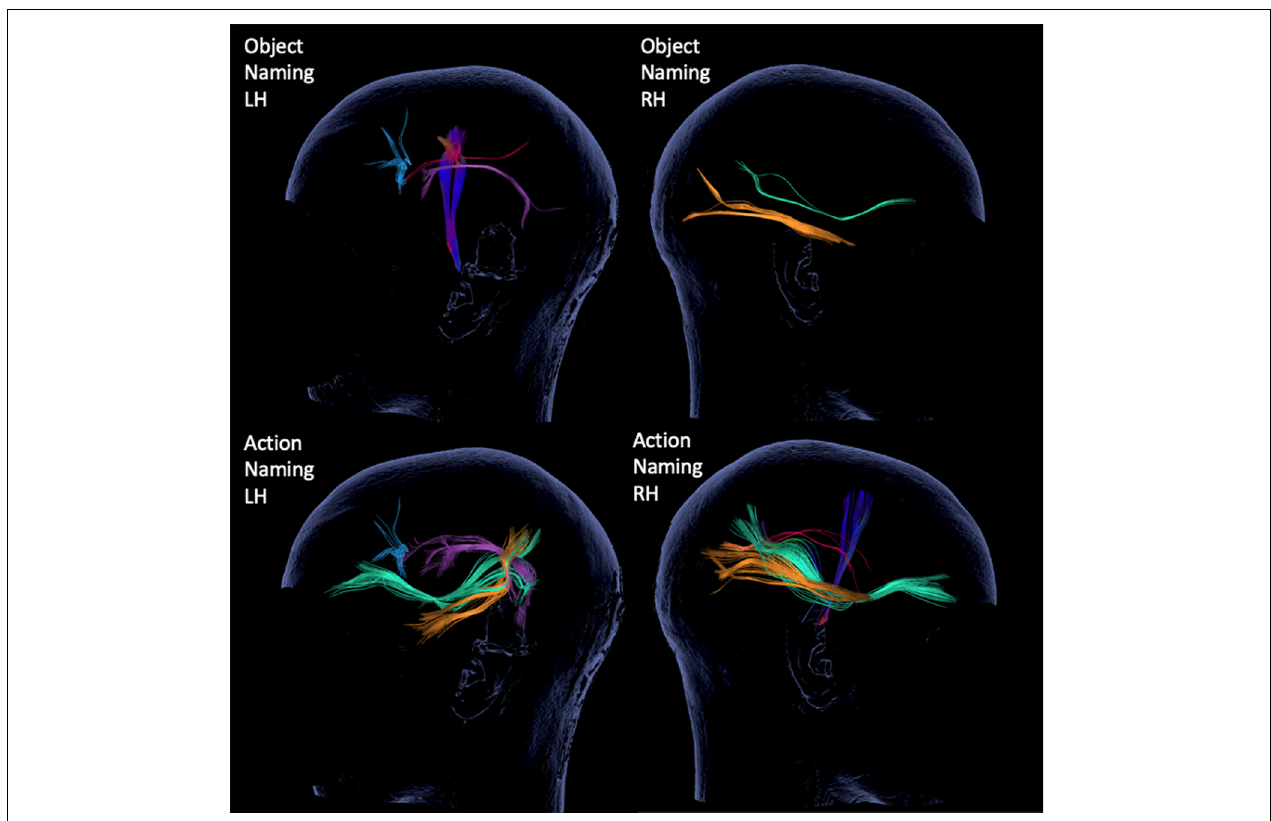
FIGURE 3 | 3D tractography results for each of the tests and hemispheres from representative case P7. The inspected tracts are color-coded as follows: AF in purple, SLF in red, ILF in yellow, IFOF in green, CF in blue and CNT with direction defined coloring, here in dark blue.